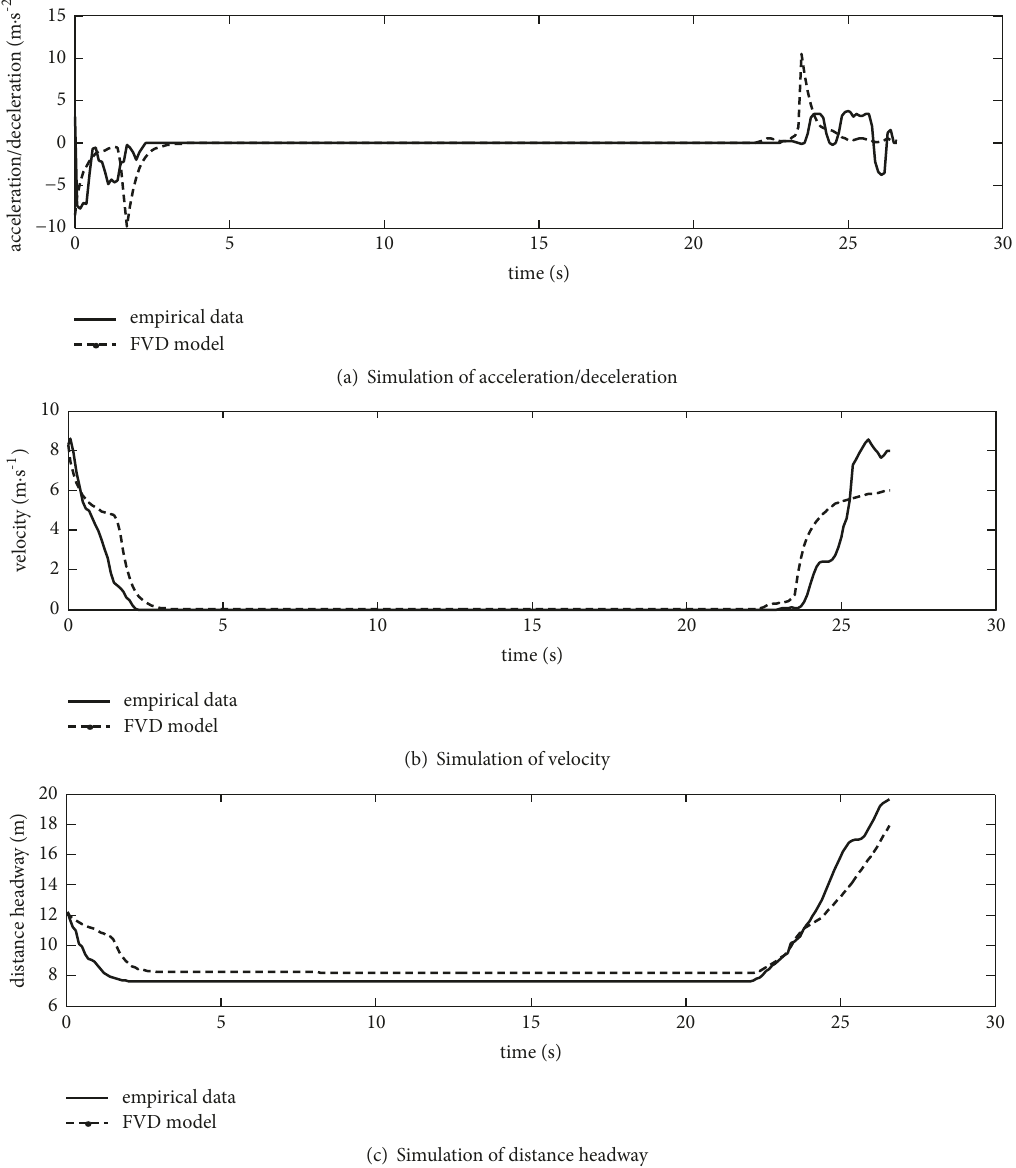
Figure 8: FVD model simulations of car-following Process